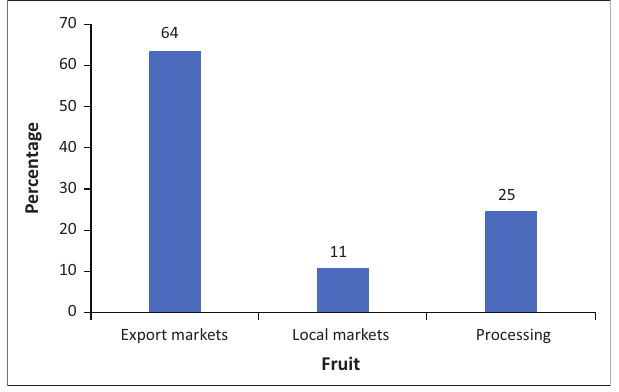
FIGURE 3: South African citrus